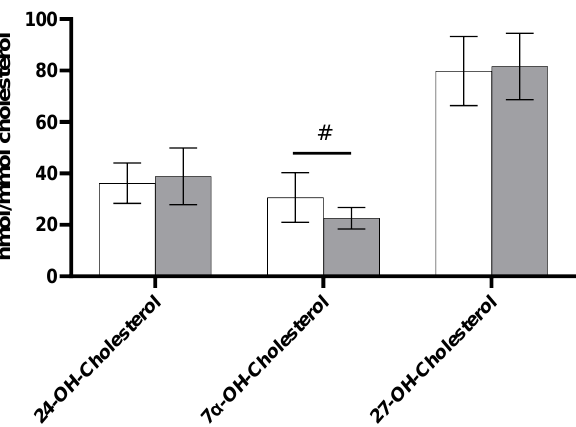
Figure 4. Values at baseline (white bars) and 24 h after LPS infusion (grey bars) for cholesterol- standardized oxysterols ( n = 8). Data are presented as means ± SEM. # p = 0.050: trend compared with baseline.